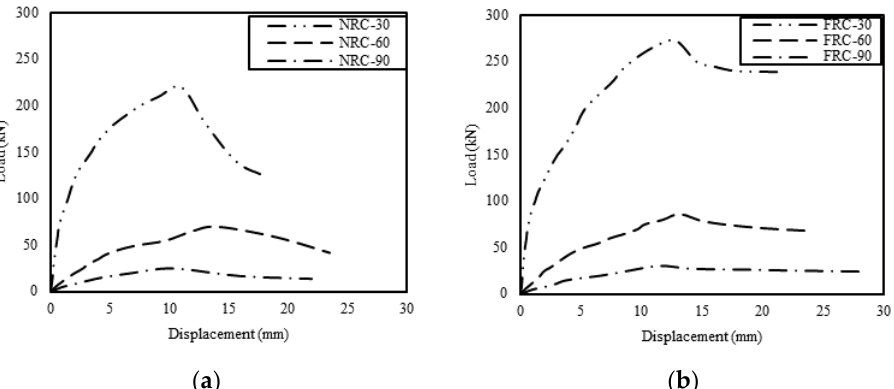
Figure 15. Load–vertical deflection comparison between V-shaped columns of ( a ) NSC and